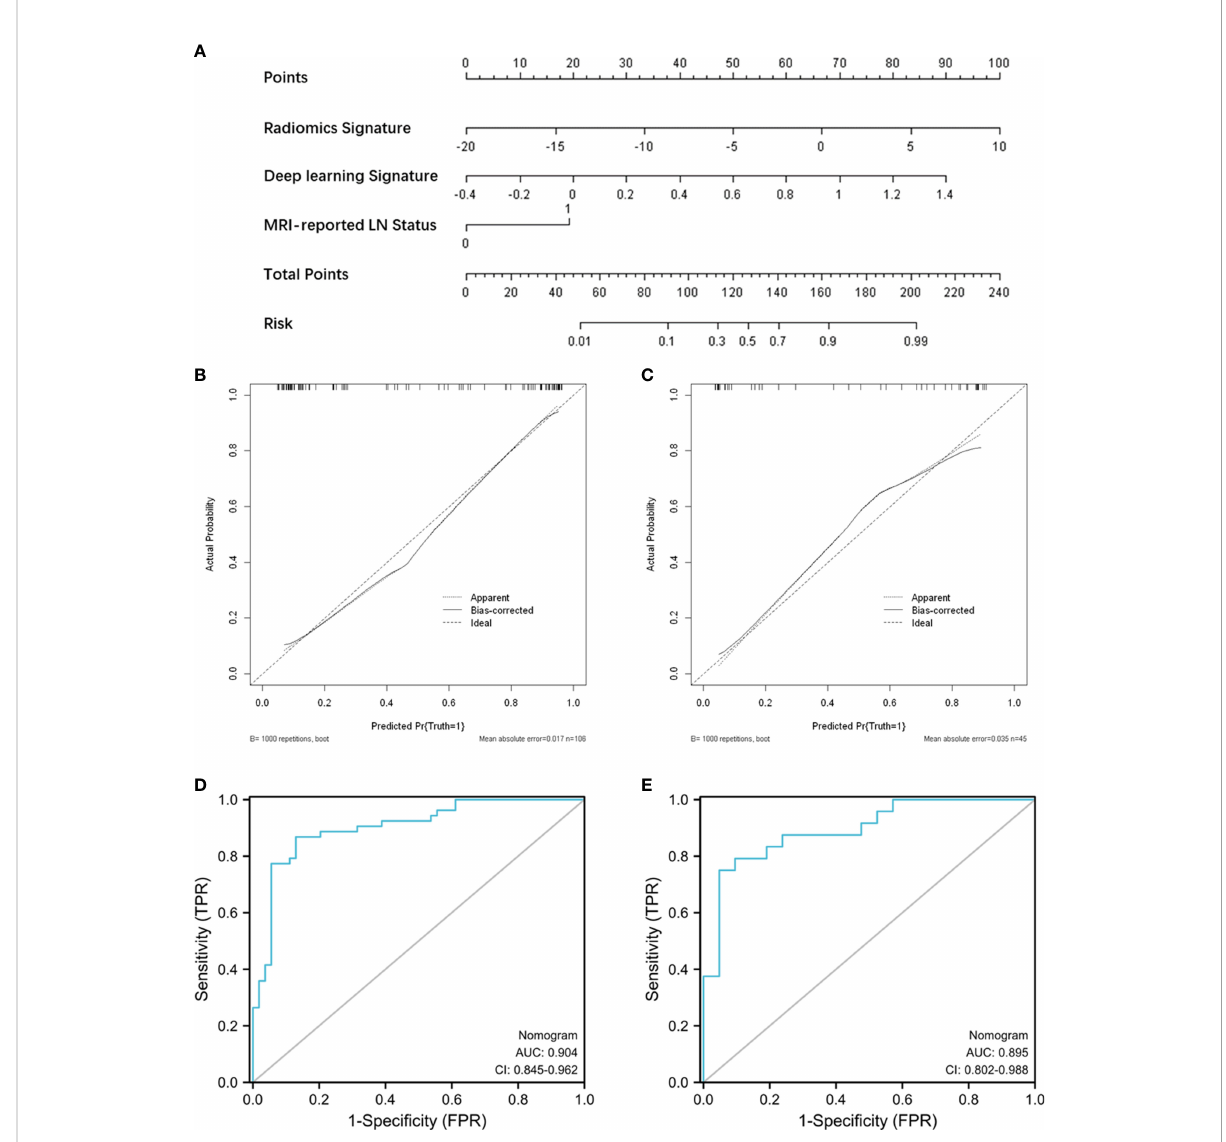
FIGURE 4 Nomogram construction and performance assessment. (A) Nomogram for prediction of ALN metastasis using the radiomics signature, deep- learning signature, and MRI-reported LN status. Calibration curve of the nomogram for the training cohort (B) and test cohort (C) . ROC curve of the nomogram for the training cohort (D) and test cohort (E)